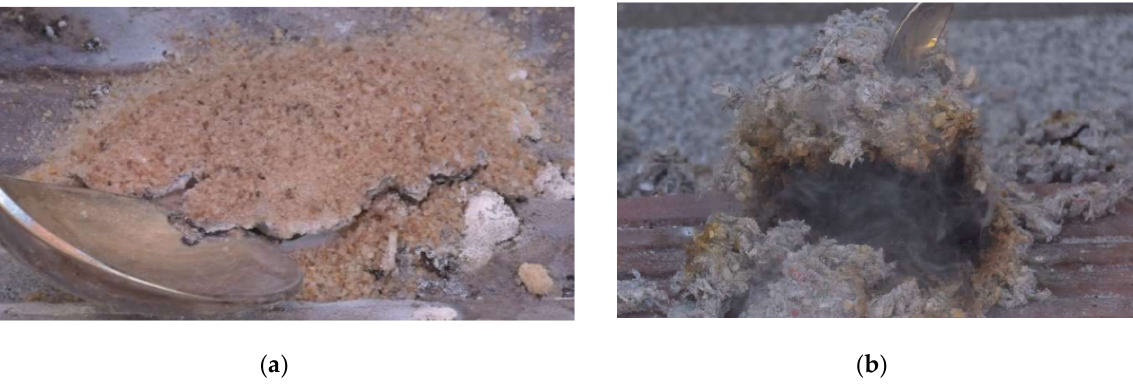
Figure 3. ( a ) Dry sand (5 g ) to extinguish a fire of 2 g Mg flakes. The crust is brittle. ( b ) Unexpectedly, 5 g of cellulose flakes placed over 2 g of burning Mg immediately stopped the flames. The material started to char. After 7–9 s, the flames partly emerged again from the charred cover. This observation was the basis for the subsequent salt additions and optimizations.